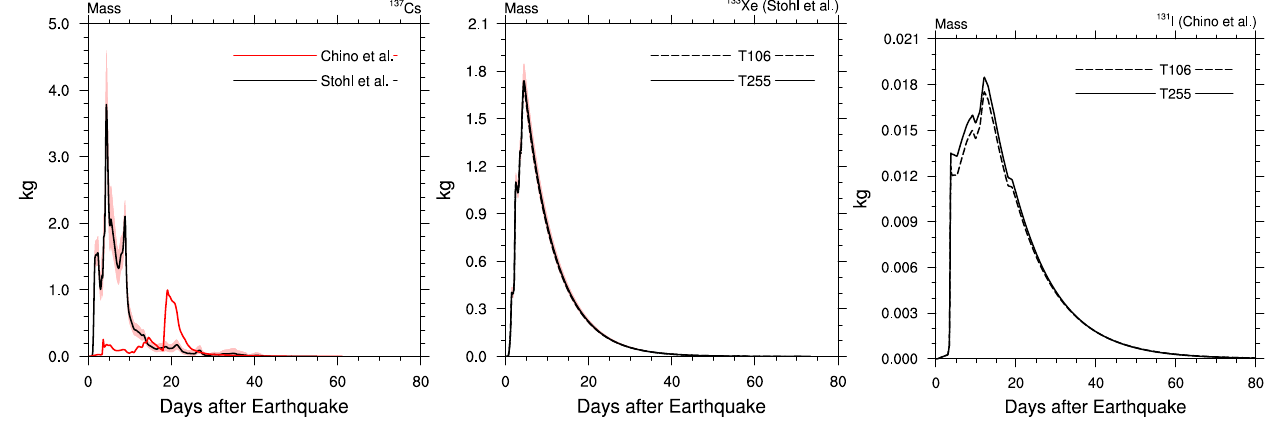
Fig. 2. Total atmospheric content (in kg) of 137 Cs (left) and 133 Xe (middle) and 131 I (right) that originated from Fukushima Dai-ichi based on the emissions inventories by Stohl et al. (2012) and Chino et al. (2011). The red bands indicate the reported range of the emission source estimates, and the dashed lines correspond to the results of the T106 horizontal resolution simulation.